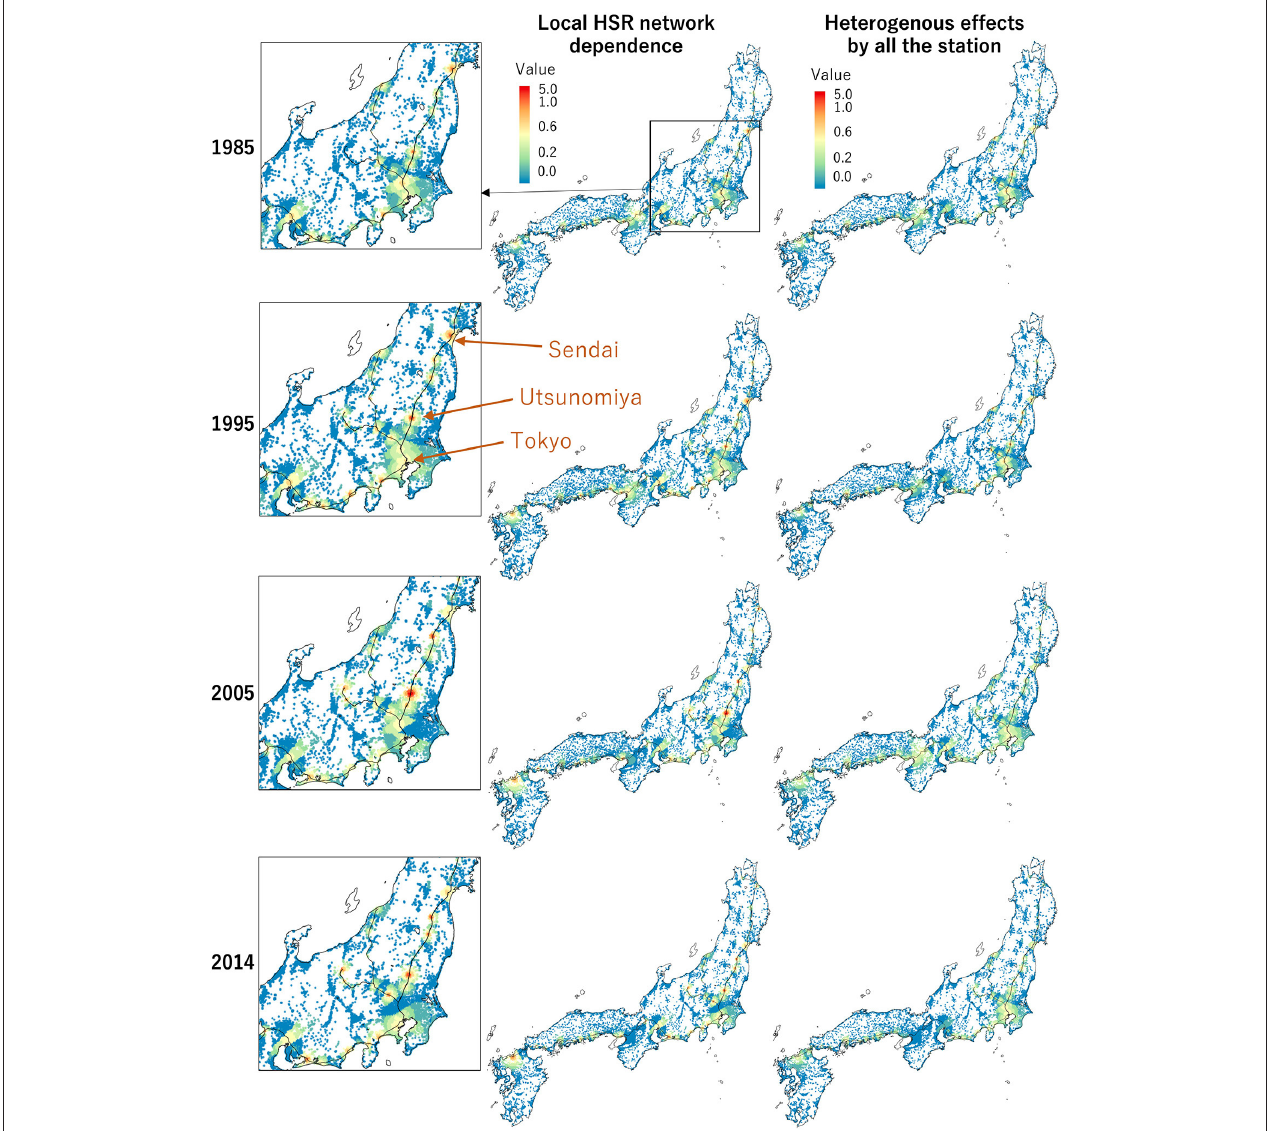
FIGURE 8 | Estimated spatial dependent effects and spill-over effects from the local network dependence through the HSR (1985, 1995, 2005, 2014). The former around Tokyo is zoomed. See Figure 7 for the color